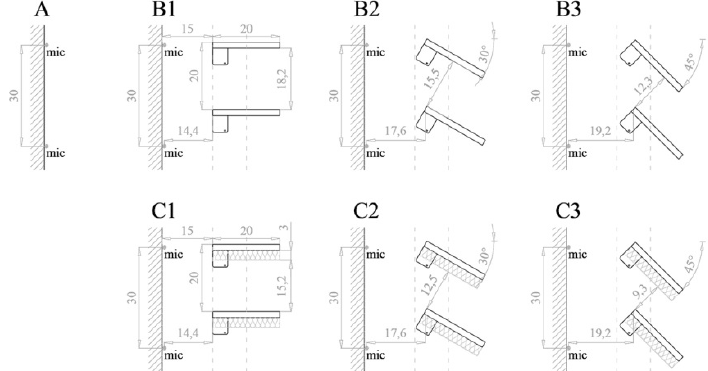
Figure 4. Setup of the different configurations: ( A ) without shading system; ( B1 – B3 ) different tilt angles of the traditional shading system; and ( C1 – C3 ) different tilt angles of the shading system with absorbing material. The dimensions are given in cm.